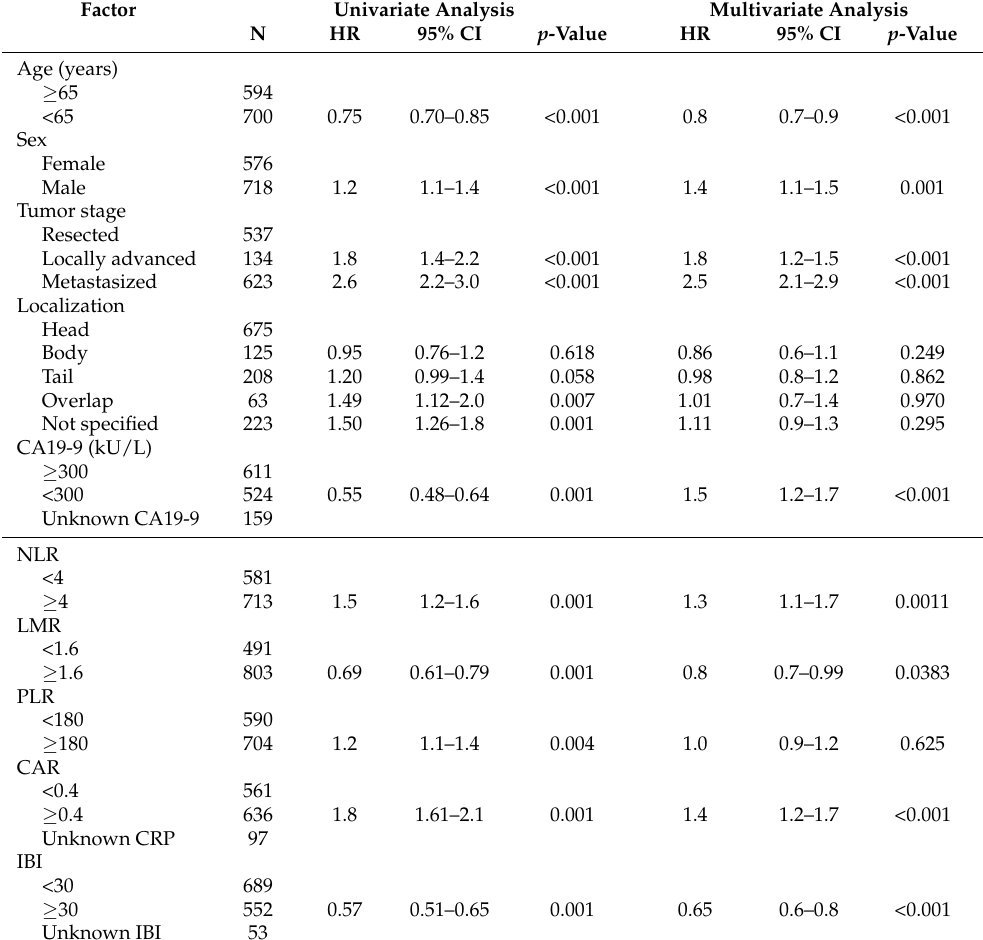
Table 3. Univariate and multivariate logistic regression analyses of study